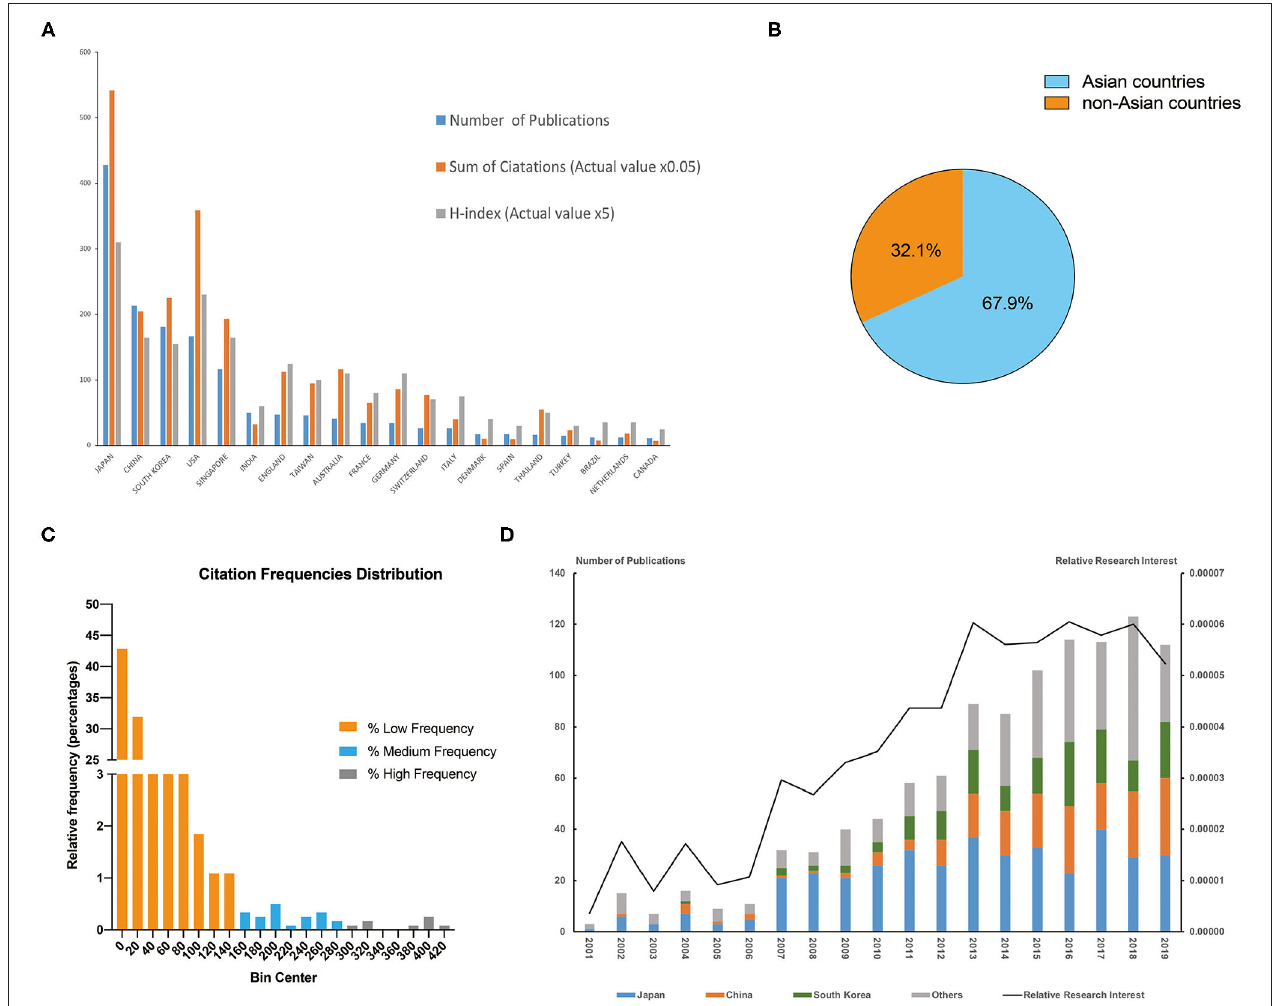
FIGURE 1 | (A) top 20 countries (regions) in the PCV publications. The blue bar showed the number of publications, orange bar showed the sum of citations in total (actual value multiply by 0.05), gray bar showed the H-index (actual value multiply by 5). (B) The proportion of publication numbers of Asian countries/regions and non-Asian countries. (C) The distribution of total citation numbers; The publications were divided into three groups according to the total citation frequencies, including high frequency of citations (more than 280 citations), medium frequency (more than 140 citations and < 280 citations) and low frequency ( < 140 citations). (D) The relative research interest (RRI) and proportion of Japan, China, South Korea and others of each year in the field of PCV. The left axis represented the number publications, while the right axis represented the relative research